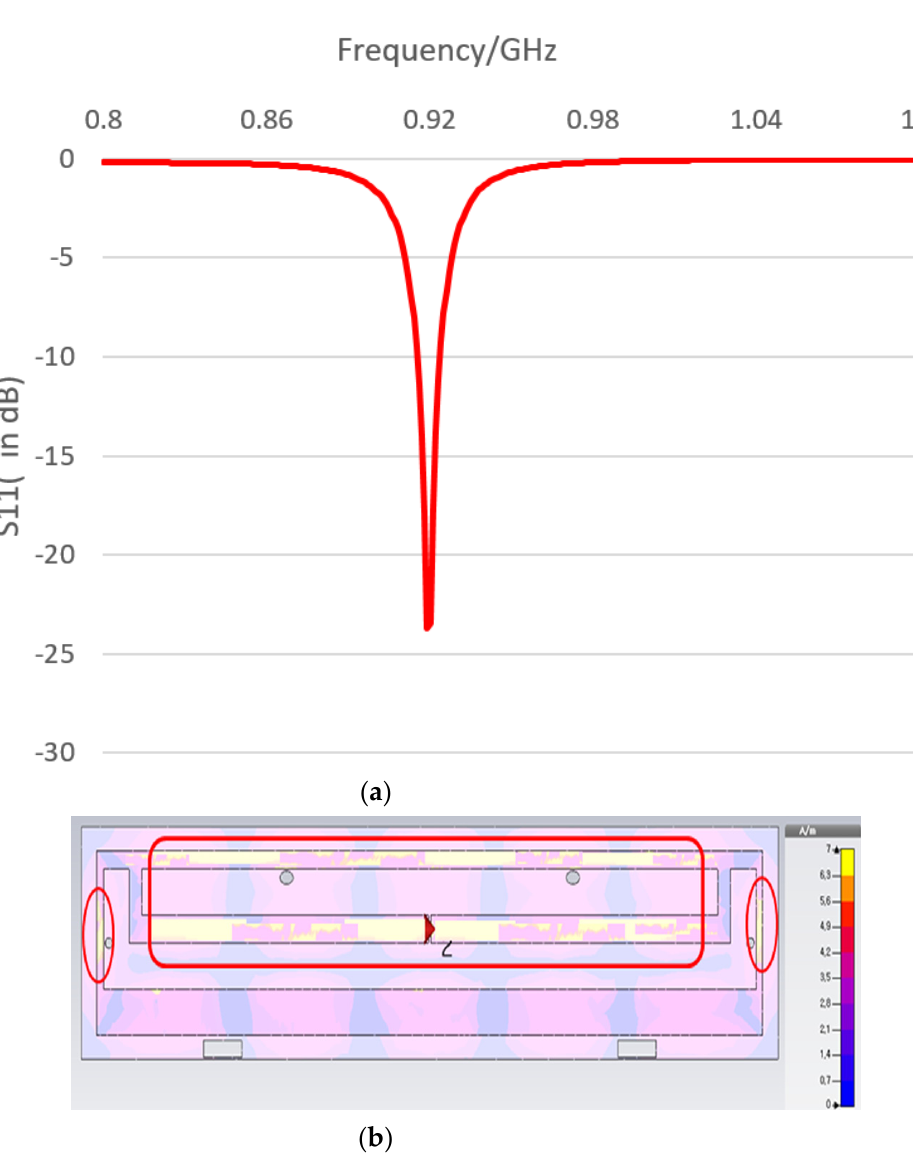
Figure 6. ( a ) Simulated return loss of tag antenna at 920 MHz. ( b ) Current density of the tag antenna at 920 MHz.